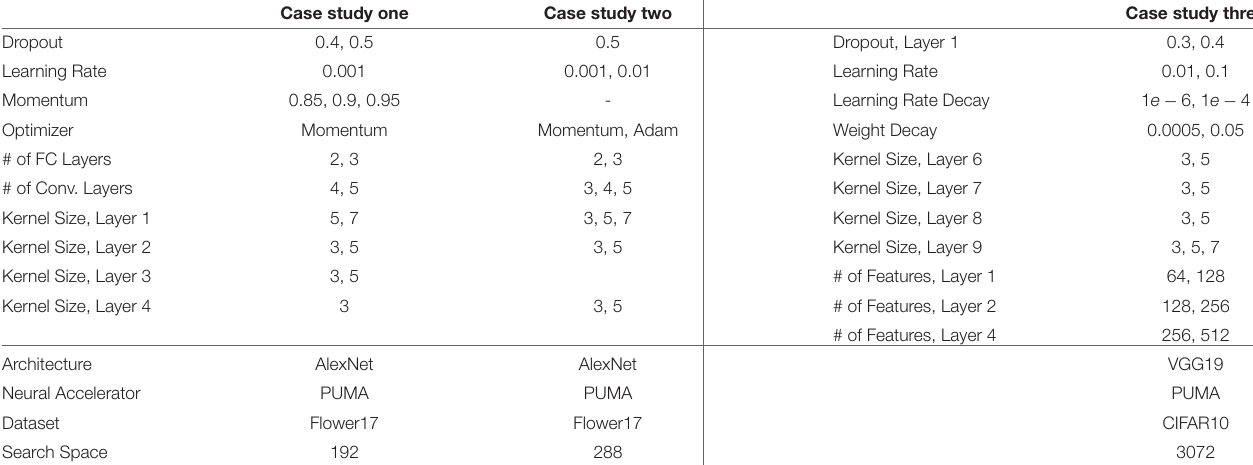
TABLE 3 | Evaluated parameters for three different case studies for